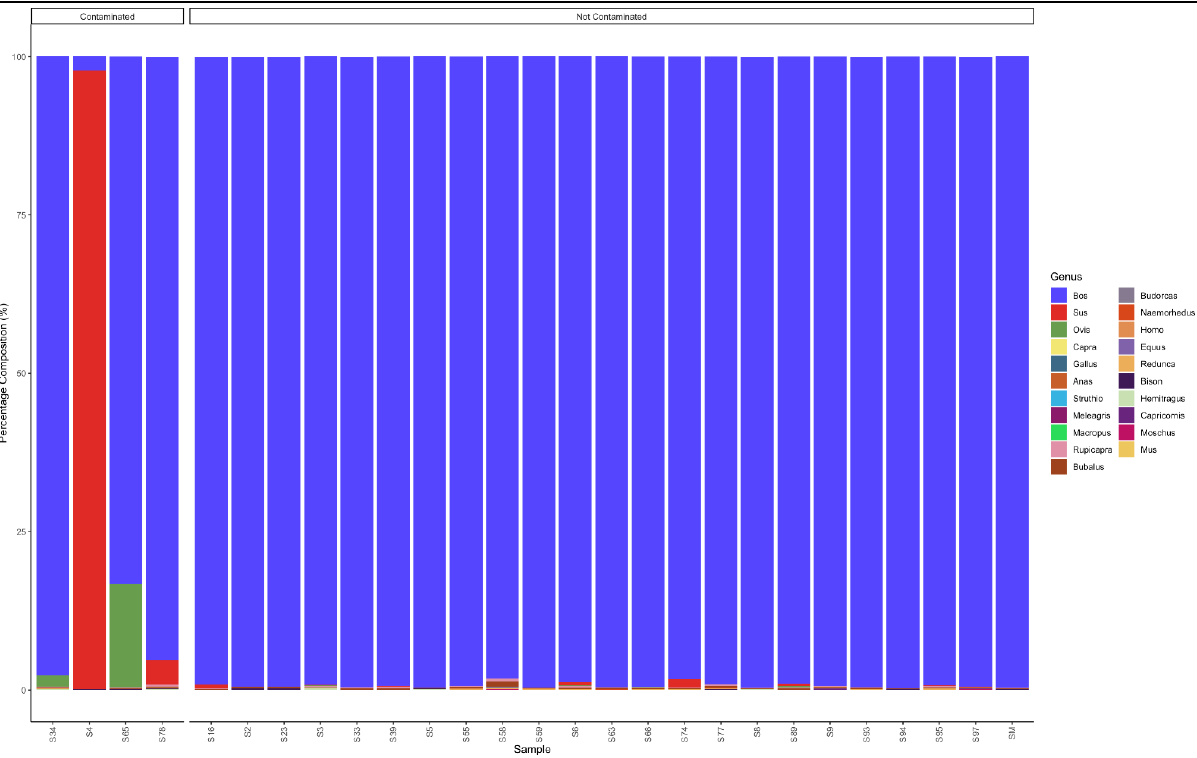
Figure 6. Percentage composition of mince samples that had not specified which species they were from.